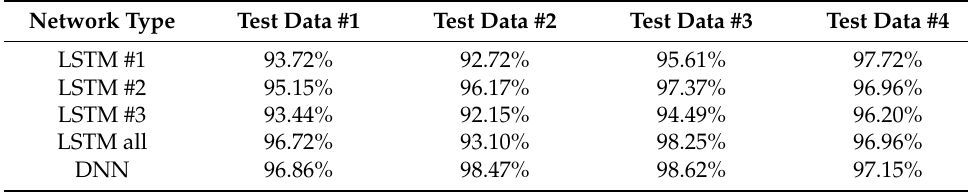
Table 2. The accuracy of each sub-neural network on the test